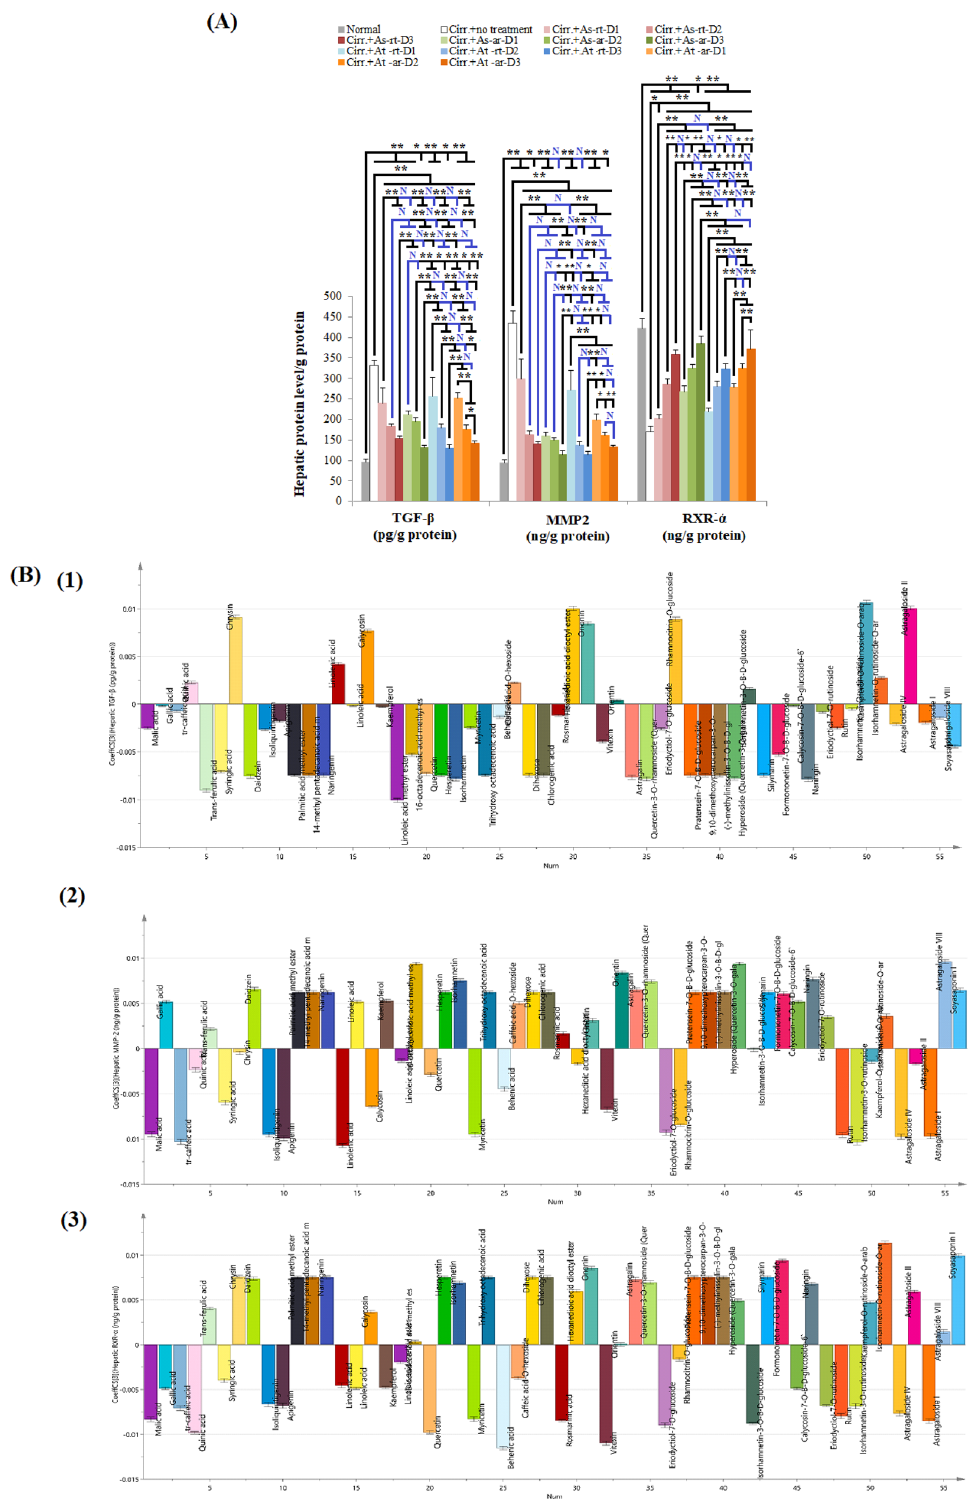
Figure 4. The effect of different Astragalus extracts on liver cirrhosis markers and their coefficient plot of OPLS model. ( A ): Comparison between different groups according to hepatic concentration of different cirrhosis parameters, ( B ): Coefficient plot of OPLS model for liver cirrhosis parameters; (1) TGF- (2) MMP-2 (3) RXR. ANOVA test was used to compare between the different ꞵ groups with Post Hoc Test (Tukey) to compare different groups. *: Statistically significant at p ≤ 0.05, **: Statistically significant at p ≤ 0.001, N: Statistically non-significant ( p > 0.05), n = 8; all results are presented as mean ± SD. (Cirr.: induced cirrhosis by i.p. administration of CCl 4 (diluted 1:6 with mineral oil) as follows: The first 10 doses were received every 5 days, the subsequent 10 doses were administered every 4 days, and the last 7 doses were given every 3 days, As: Astragalus spinosus , At: Astragalus trigonus , ar: aerial organs, rt: root organs, D1: low dose, D2: medium dose, D3: high dose, MMP2: matrix metalloproteinase 2, TGF- : transforming ꞵ growth factor beta, RXR: retinoid-X receptor, ALT: Alanine aminotransferase and AST: aspartate